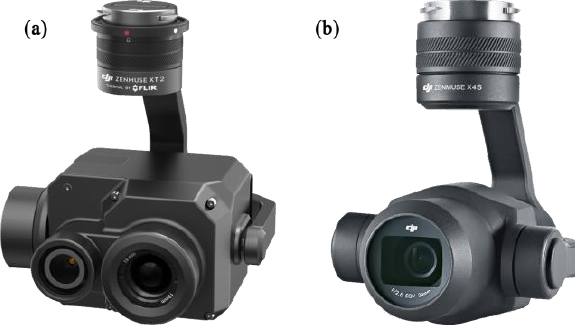
Figure 8. (a) DJI Zenmuse XT2 and (b) DJI Zenmuse X4S.